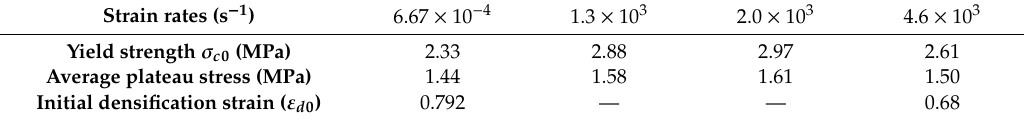
Table 6. Yield strength, average plateau stress and initial densification strain at di ff erent strain